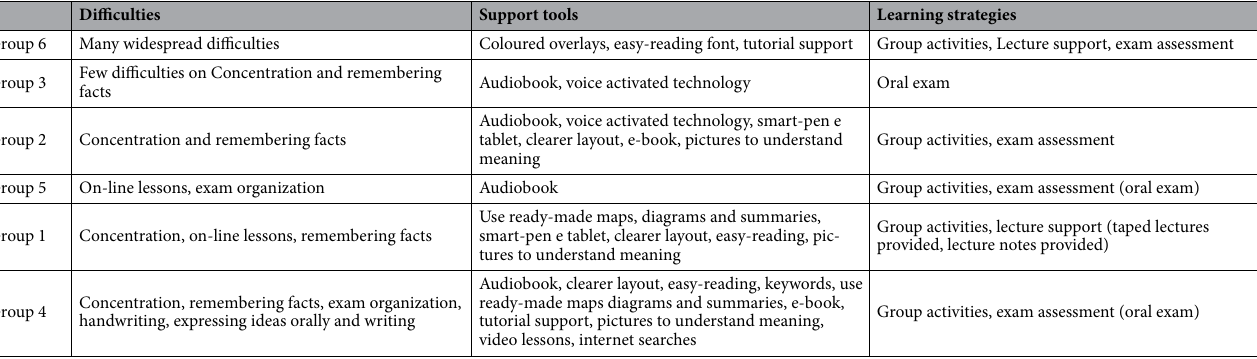
Table 3. Difficulties, support tools and learning strategies by